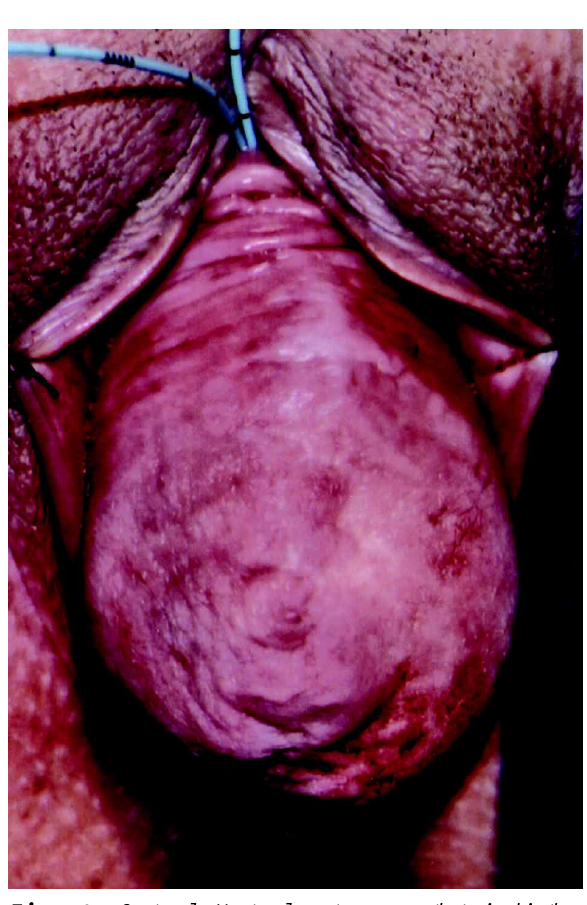
Figure 1 – Cystocele. Ureteral meatus were catheterized in the beginning of the surgery.